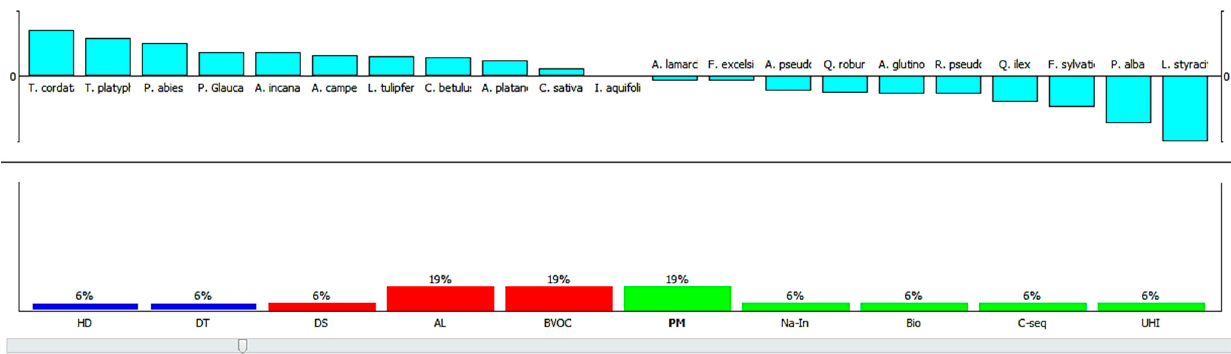
Figure 2. Ranking of plant species is shown in the upper part of the bar chart according to scenario (S1) PM mitigation and reduced EDs. The lower part of the bar chart shows an equally high importance for allergenicity, BVOC emissions (red bars), and PM mitigation. The criteria including hardiness, drought tolerance (dark blue bars), disease susceptibility (red bar), native-invasive, supporting biodiversity, net carbon sequestration, and reducing urban heat island effect (green bars) are adjusted as having low importance. Plant species are ordered from best to worst. (For an interpretation of the references to color in this figure legend, the reader is referred to the web version of this article.)